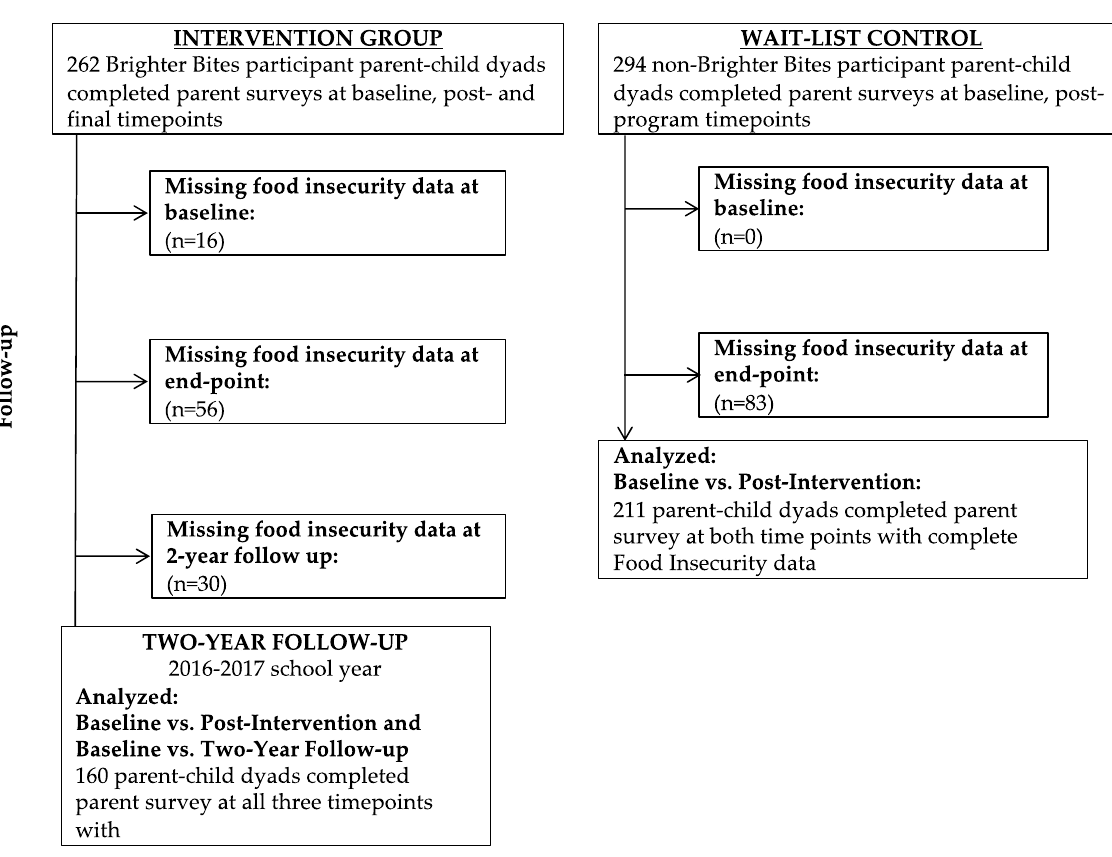
Figure 1. Study flow of analysis of food insecurity from a two-year longitudinal follow-up evaluation of Brighter Bites .